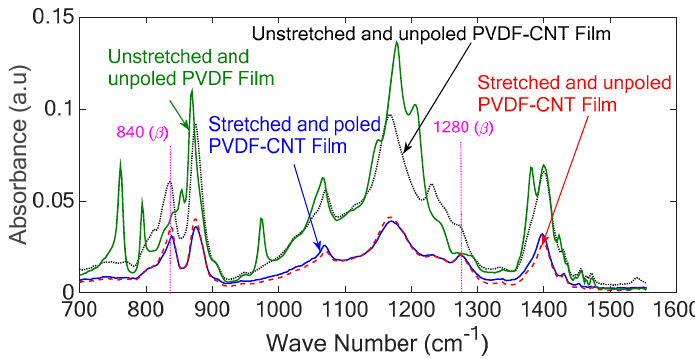
Figure 5. Fourier transform infrared spectroscopy (FTIR) of the PVDF and PVDF-carbon nanotube (CNT) samples before and after stretching.